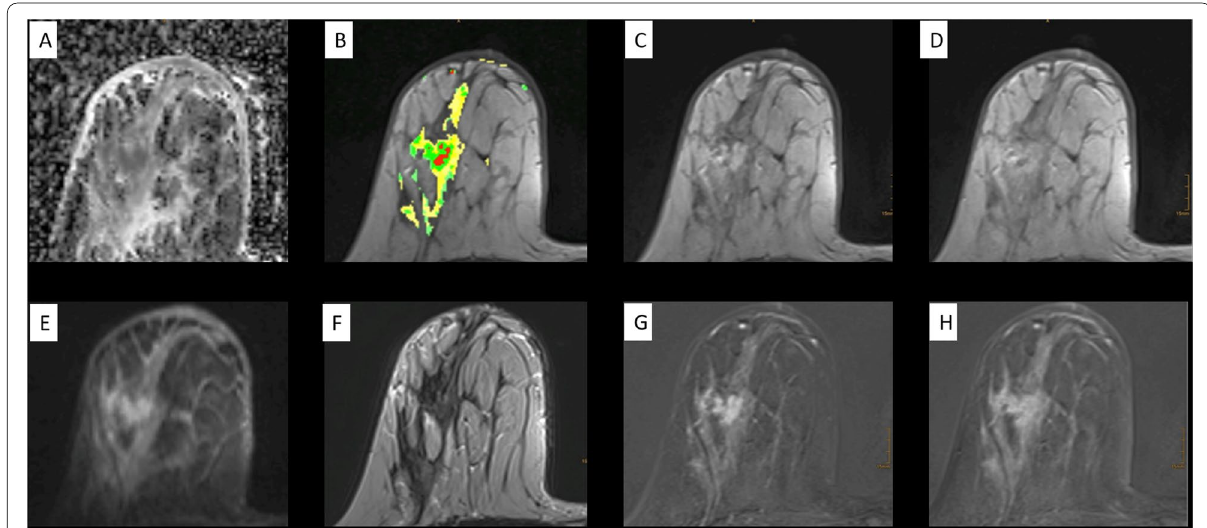
Fig. 2 Standardised reading setup for comprehensive diagnostic and predictive/prognostic breast magnetic resonance imaging (MRI) at one‑stop shop. A female patient with suspicious amorphous segmental calcifications on the right breast at mammography, breast imaging reporting and data system (BI‑RADS) 4 diagnostic category (not shown). MRI was performed also for preoperative staging due to suspicion of extended ductal carcinoma in situ . Diagnostic MRI shows an extensive heterogeneous segmental non‑mass enhancement predominantly with plateau dynamic pattern. A noncircumscribed mass with washout and heterogeneous internal enhancement (BI‑RADS 5 diagnostic category) is located centrally within the non‑mass lesions. Relevant prognostic findings are here washout, skin thickening, invasion of the nipple, and diffuse ipsilateral oedema (see also Figs. 5 and 6). Semantic criteria correspond to the MRI phenotype of an aggressive invasive breast cancer. P2‑MRI results were confirmed by postoperative pathological examination (invasive cancer NOS, G3, Ki‑67 , triple negative, node positive). Apparent diffusion coefficient map +++ ( A ); unenhanced T1‑weighted gradient echo with colour overlap of the dynamic curve on a pixel‑by‑pixel basis (green/yellow/red persistent/ = plateau/washout) ( B ); first ( C ) and last ( D ) contrast‑enhanced T1 GRE; diffusion‑weighted imaging obtained with b 800 s/mm 2 ( E ); T2‑weighted = turbo spin‑echo ( F ); first ( G ) and last ( H ) contrast‑enhanced subtractions. Diffusion‑weighted imaging findings are highlighted in Fig.